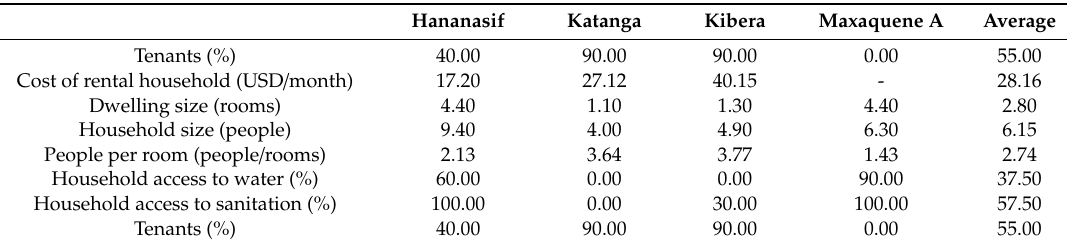
Table 1. Interview data.